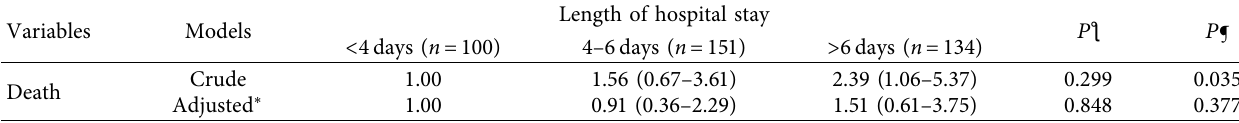
Table 4: Crude and adjusted cox regression hazard ratio of death according to the length of hospital stay.